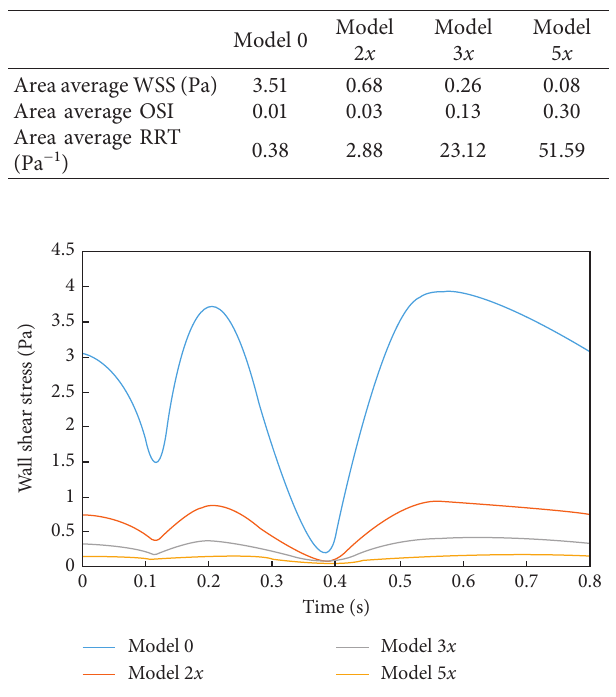
Figure 5: Wall shear stress in the coronary artery aneurysm over a cardiac cycle for the four